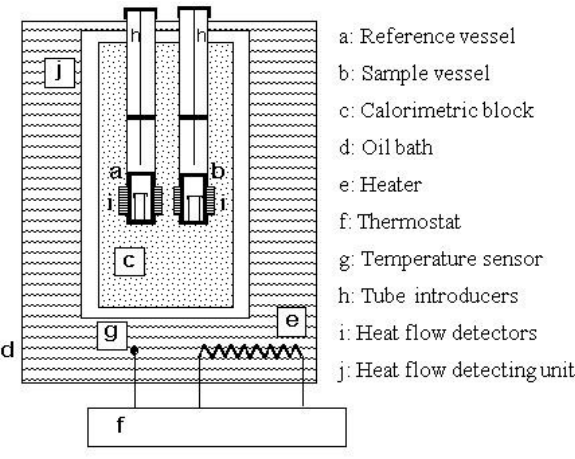
Figure 3. Schematic diagram of TAM-III thermometric